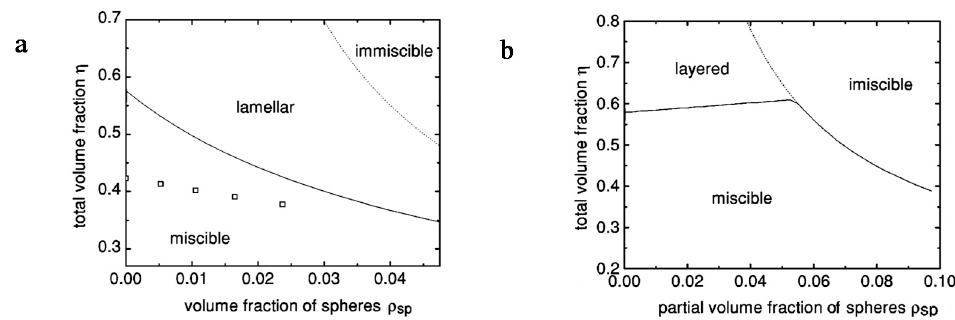
Figure 10. Phase diagrams of mixtures of spherocylinders ( L/D ) sc = 20 and D sc /D p = 1, squares are results of computer simulations at which the lamellar transition is observed ( a ) small or ( b ) example effects of large diameter spheres for ( L/D ) sc = 10 and D sc /D sp = 0.15. Reprinted with permission from Dogic, Z.; Frenkel, D.; Fraden, S. Enhanced stability of layered phases in parallel hard